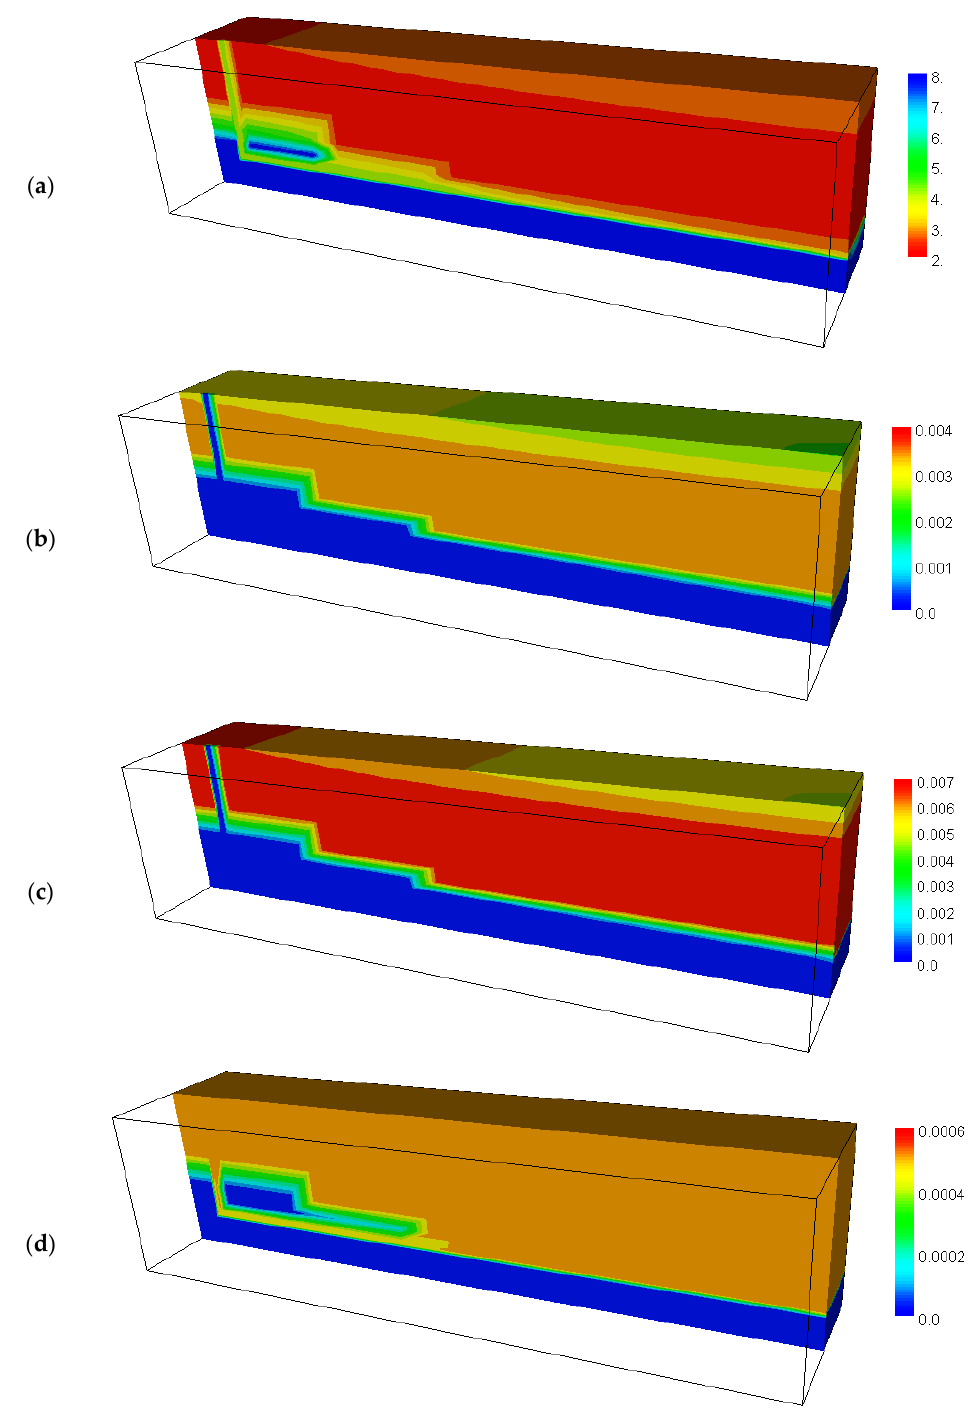
Figure 6. Distribution of pH ( a ), total iron concentration (mol/L) ( b ), sulfate ion concentration (mol/L) ( c ), and dissolved oxygen concentration before backfilling (mol/L as the oxygen atom) ( d ) (calculated results of case 1). 4.4. Calculated Results after Backfilling the Drift Similar to the groundwater flow before backfilling, rainwater infiltrating from the ground surface percolated through the shaft and horizontal drift. Groundwater flowed